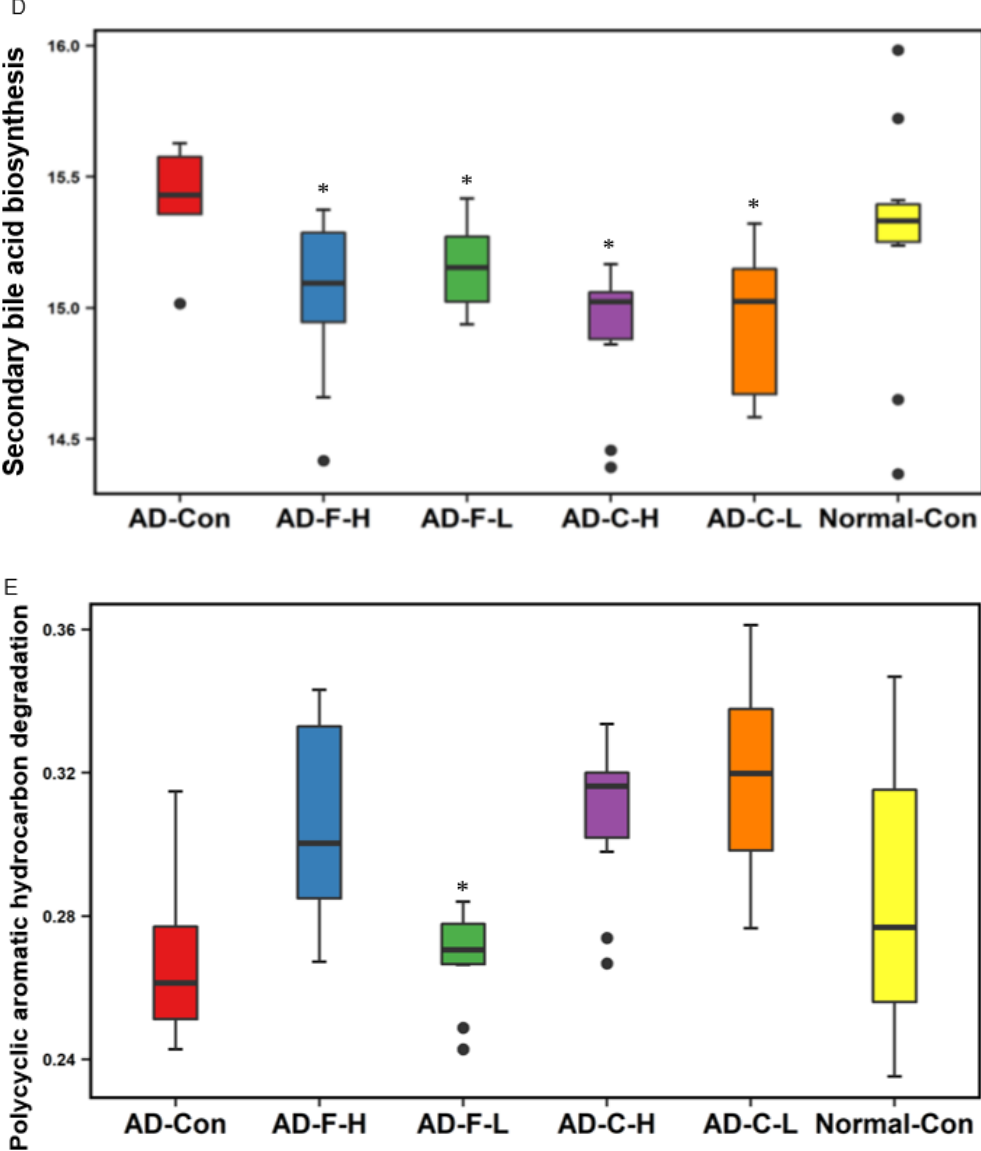
Figure 6. Metagenome function of cecum bacteria by picrust2 analysis. ( A ) Butanoate metabolism ( B ) Citrate cycle (TCA cycle, Krebs cycle) ( C ) Oxidative phosphorylation ( D ) Secondary bile acid biosynthesis ( E ) Polycyclic aromatic hydrocarbon degradation. Bars and error bars represent the means ± standard deviations (n = 10). Hippocampal amyloid- β (25–35)-infused rats were fed a high- fat diet containing dextrin (AD-Con), fucoidan with high molecular weight (AD-F-H), fucoidan with low molecular weight (AD-F-L), λ -carrageenan with high molecular weight (AD-C-H), and λ - carrageenan with low molecular weight (AD-C-L). The rats in the Normal-Con had hippocampal saline infusion to have no amyloid- β deposition and were fed a high-fat diet (Normal-Con). * Significant from the AD-Con group at p < 0.05.